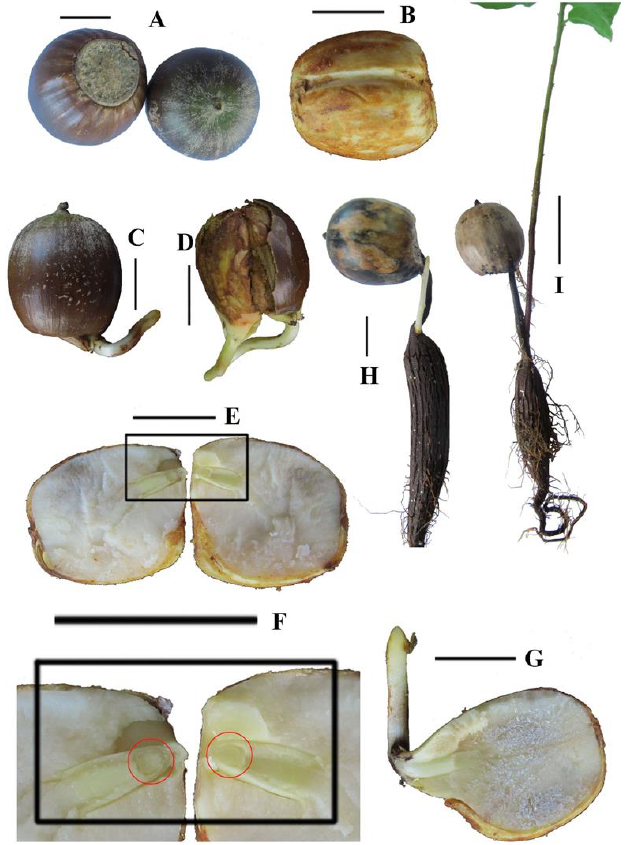
Figure 1. Fruit and seed morphology photographs of Q. chungii seed germination. A, fruit; B, seed; C-D, start of seed germination (C, one seed in one fruit; D, two seeds in one fruit); E, morphology of seeds; F, elongation of cotyledonary petiole and embryo axis (red circle); G, seed morphology after cotyledonary petiole had protruded through the fruit coat; H, shoot germination; I, seedling. In each panel, a separate scale bar of 1 cm is shown.